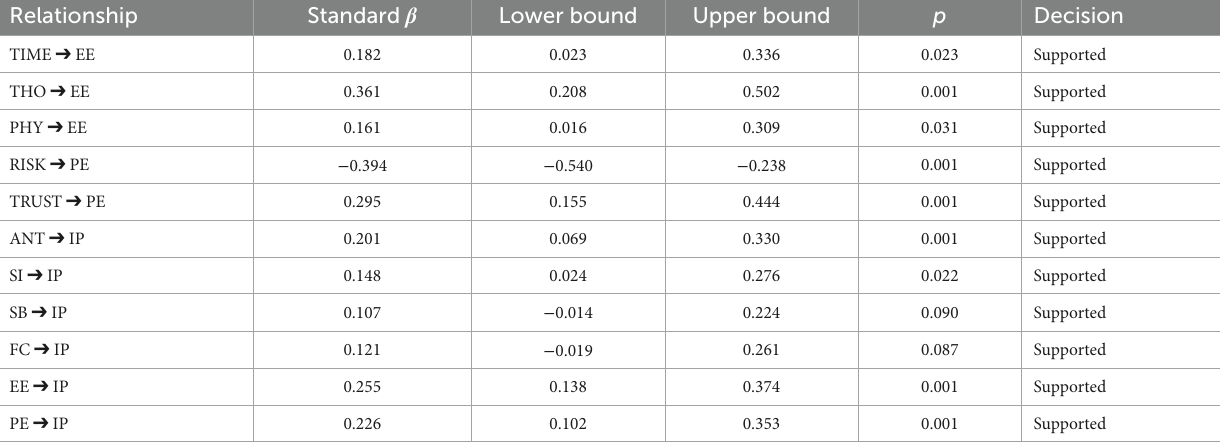
TABLE 9 The bootstrap estimation of standard path coefficients (95% percentile CI).